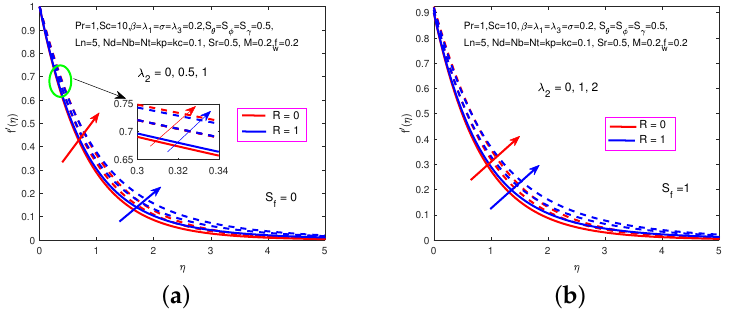
Figure 4. Influence of λ 2 and R on f (cid:48) . ( a ) No hydrodynamic slip. ( b ) With hydrodynamic slip.